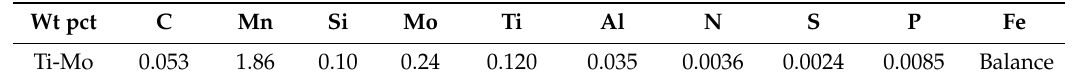
Table 1. Experimental Alloy Composition.